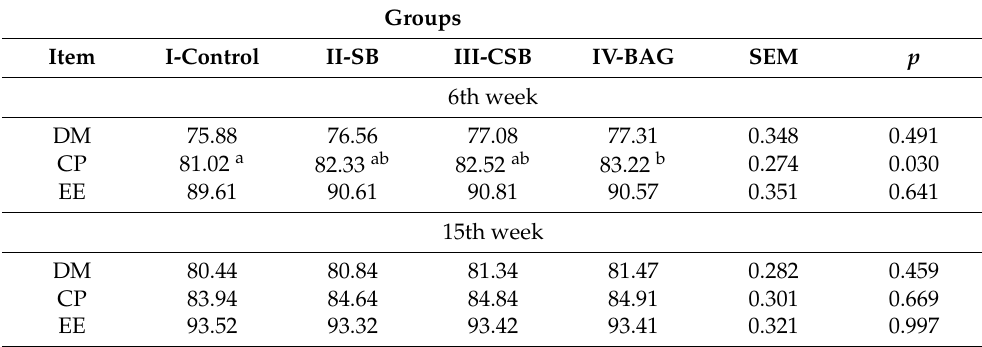
Table 3. Effect of butyric acid supplementation on the ileal nutrient digestibility in